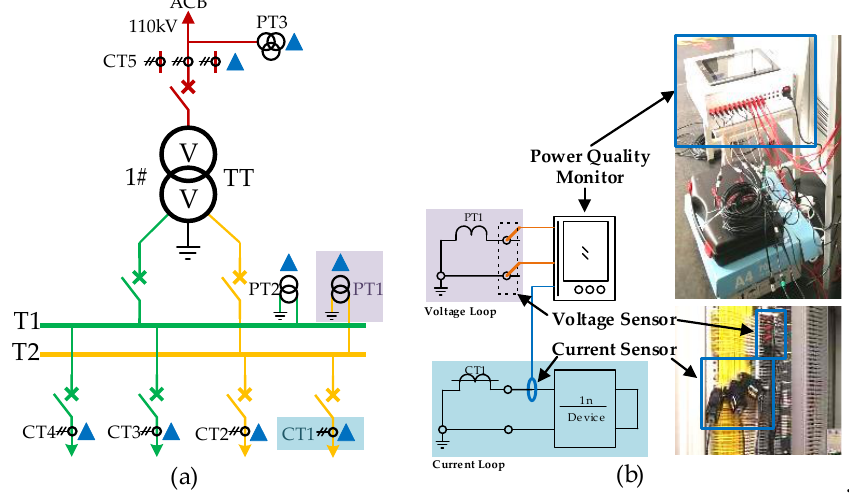
Figure 6. Power quality test in a traction substation (TSS). ( a ) Main circuit of TSS and monitoring points ( ▲ is the monitoring point); ( b ) Equipment’s connection and layout in the field. Table 2. The key parameters of the current sensor and current